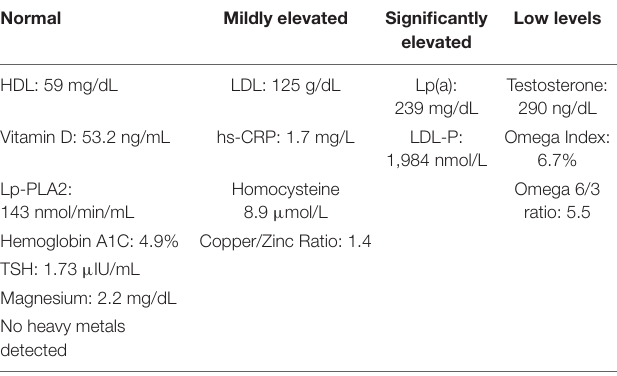
TABLE 1 | Initial serum laboratory values for Mr.